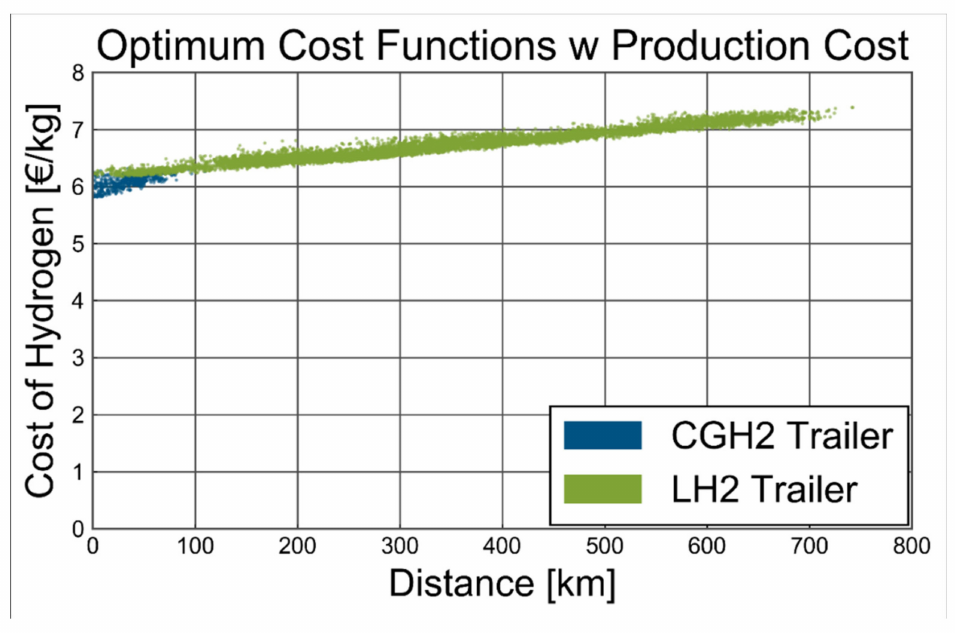
Figure 6. Optimization potential between different hydrogen transport options using trucks.